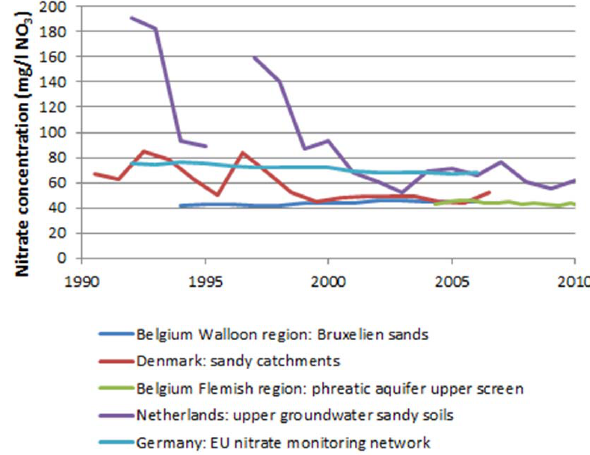
Fig. 5. Trend of nitrate concentrations in upper levels of phreatic Figure 5. Trend of nitrate concentrations in upper levels of phreatic groundwater in sandy 2 groundwater in sandy soils, catchments or aquifers in monitoring soils, catchments or aquifers in monitoring programs for the Nitrates Directive (Data taken 3 programs for the Nitrates Directive (Data taken from Fraters et al., from Fraters et al. 2011). 4